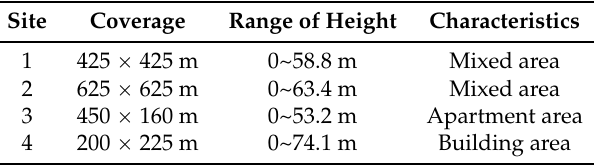
Table 1. Characteristics of experimental